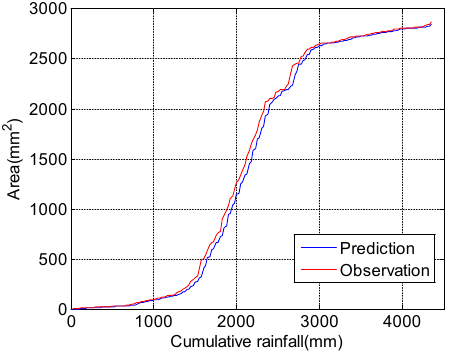
Figure 15. Prediction of moving averages method (Sample 1-25 mm/h) ( n = 174).